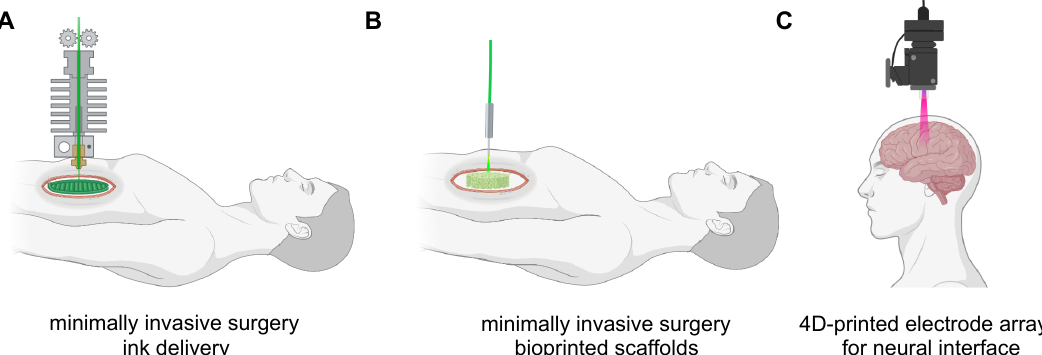
Figure 6. Schematic representation of closed-loop AI-based 4D-printing approaches for autonomous minimally invasive surgery (MIS). (A) 4D-inks delivery with biological and mechanical features mimicking the human body tissues and organs. (B) In situ bioprinting scaffolds with engineered cells to repair damage tissues/organs. (C) Surgical robot-assisted implantation of 4D-printed electrode arrays for neural interface.